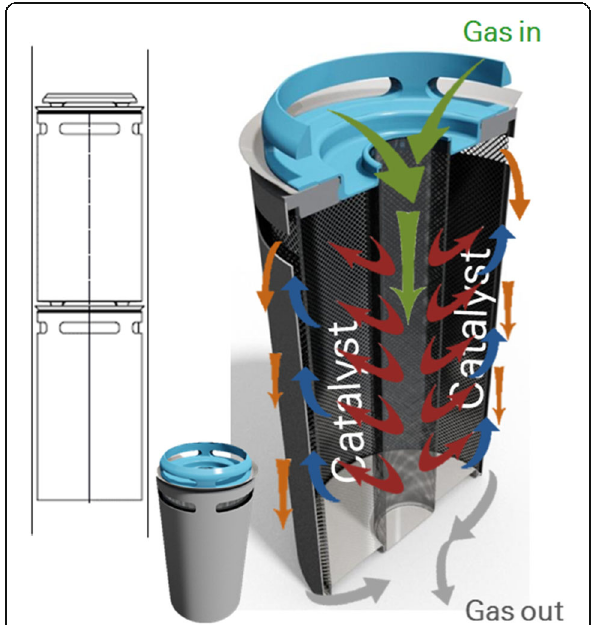
Fig. 1 Schematic of the CANS TM catalyst